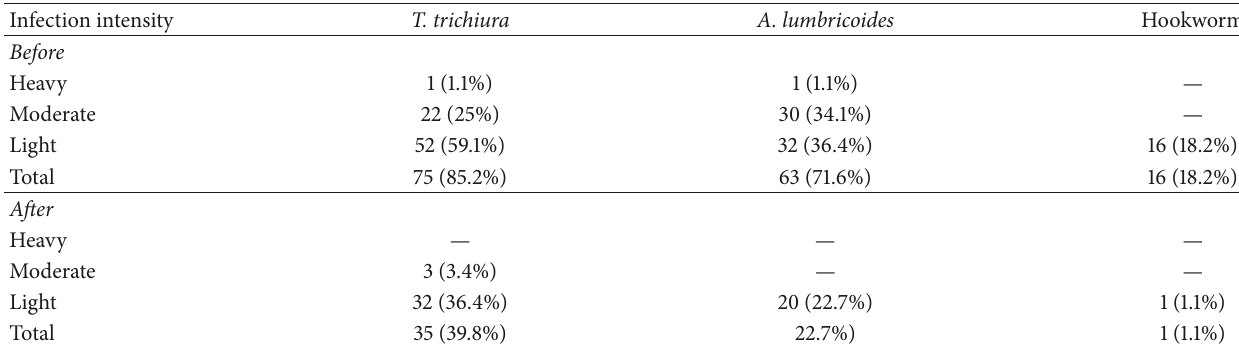
Table 3: The prevalence of STH based on intensity of infection before and after